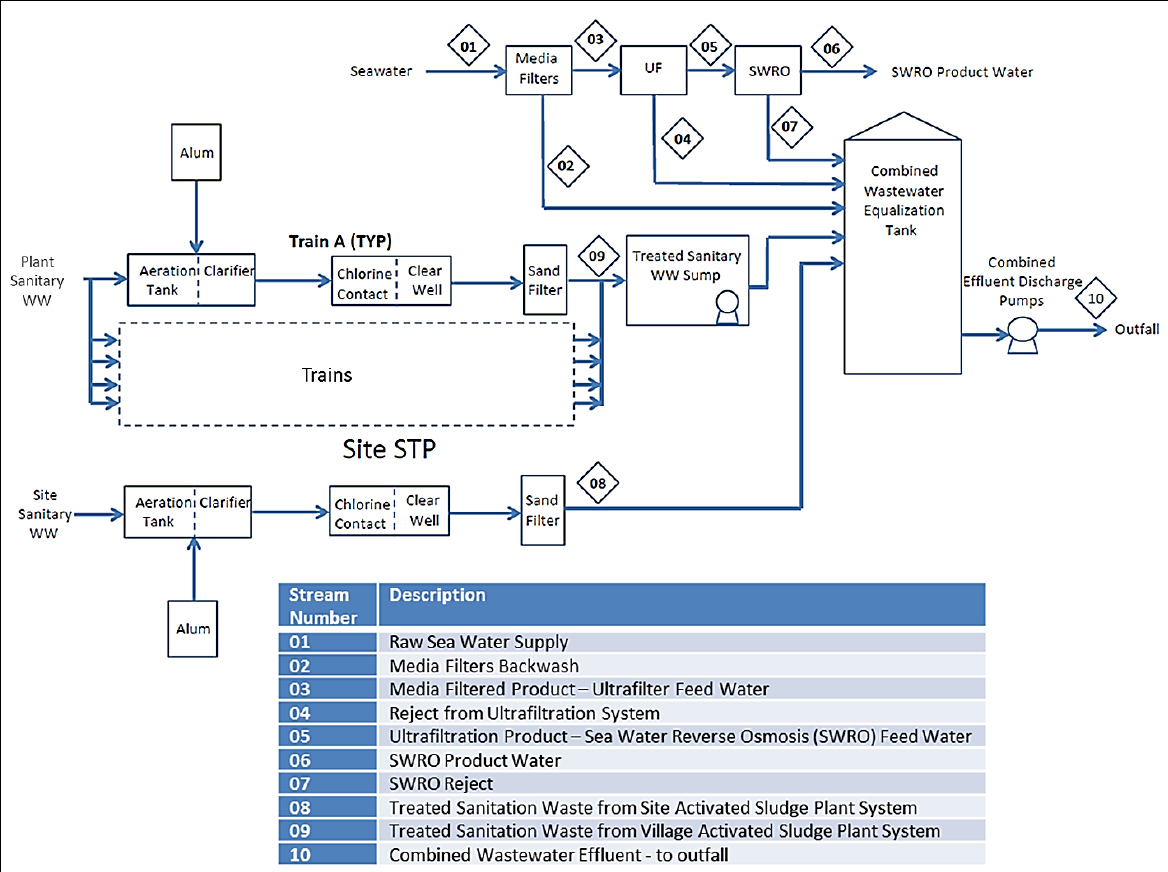
Figure 1. Schematics of a typical LNG plant wastewater process